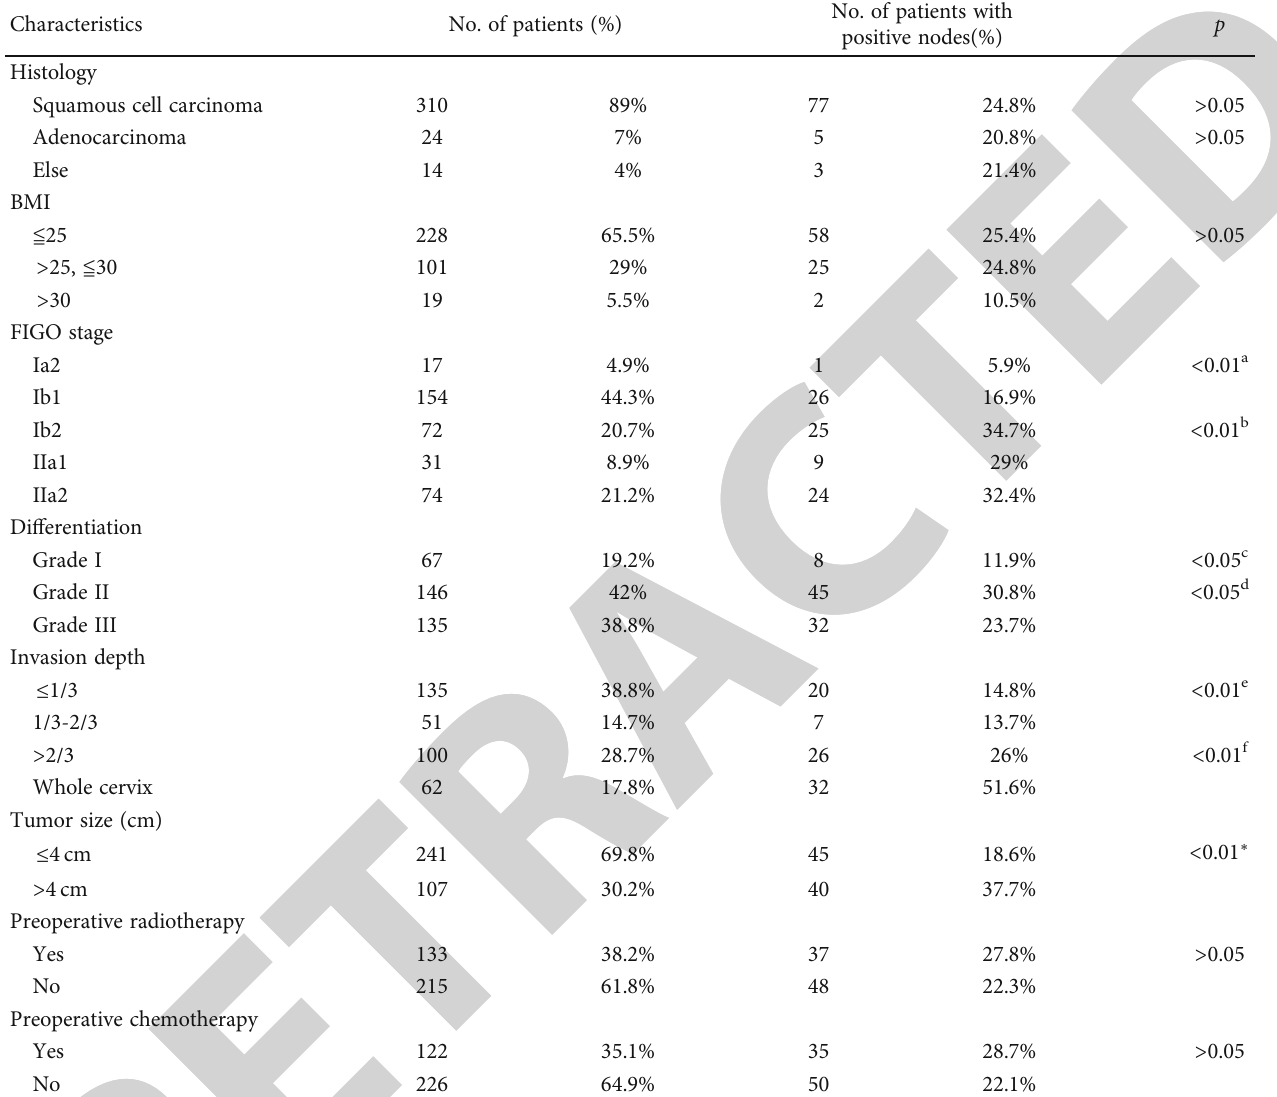
Table 1: The relationship between clinicopathological features and lymph node metastasis.